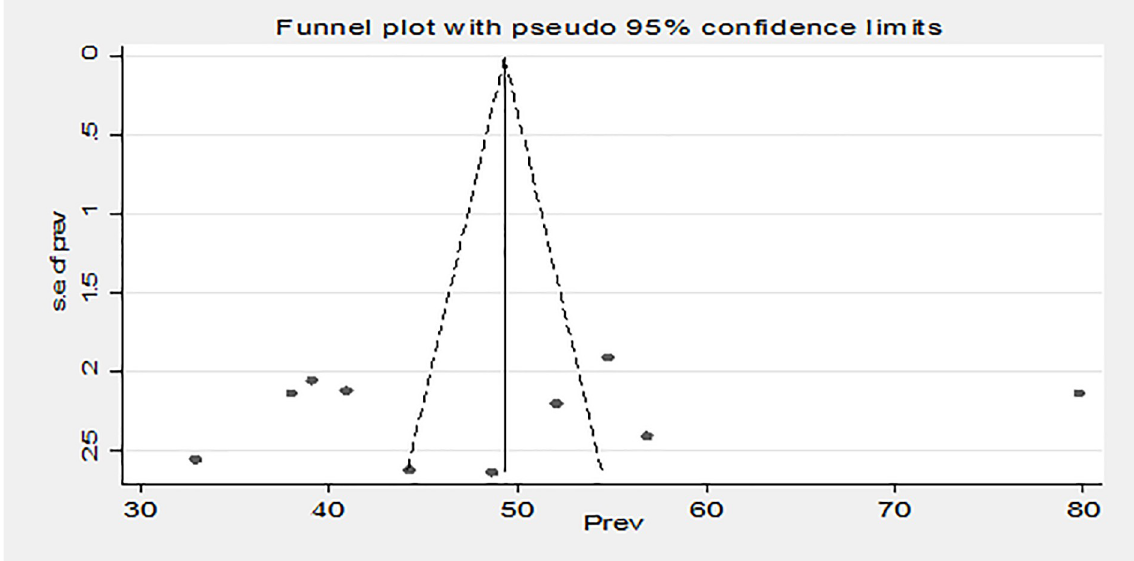
Fig 4. Funnel plot of publication bias for studies conducted in 2017 and above on the prevalence of risky sexual behavior among people living with HIV/AIDS on highly active antiretroviral therapy in Ethiopia, 2021.